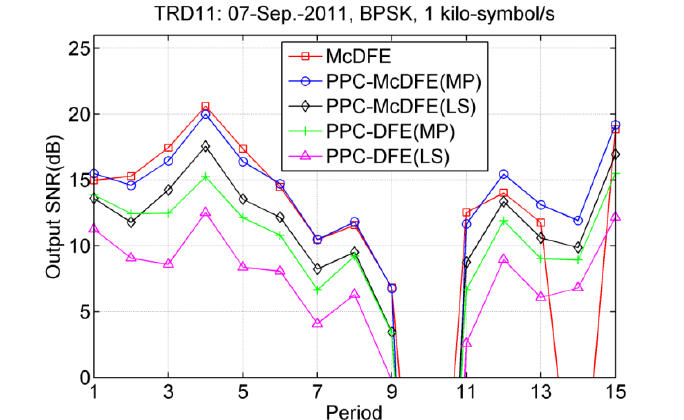
Figure 15. Performance of three receiver structures. There are 16 blocks for PPC